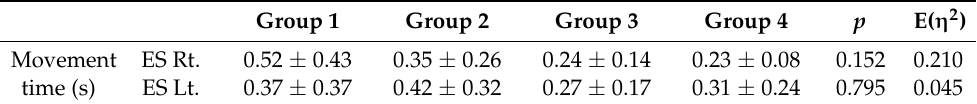
Table 4. Comparison of effect size between